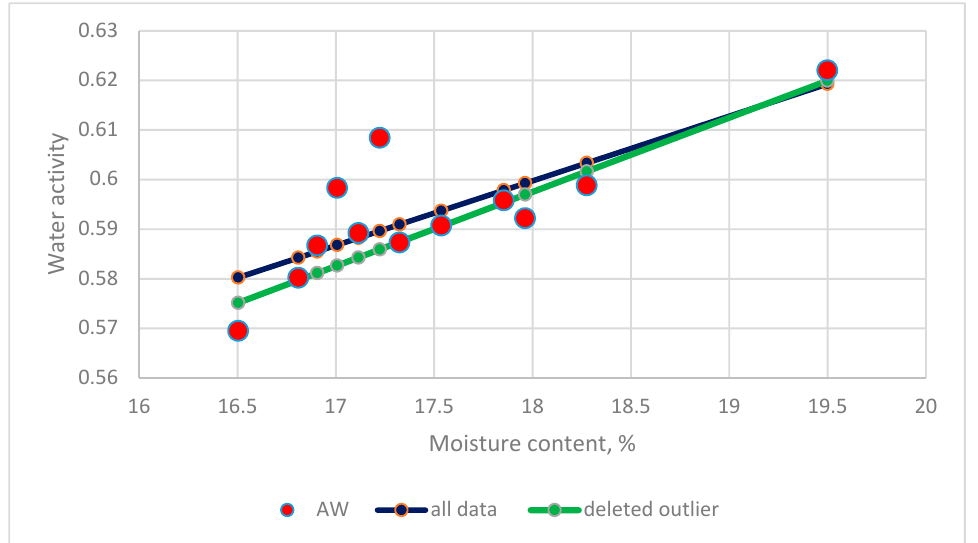
Figure 13. The comparison between two equations with and without outliers in the datasets of Sanjuan et al. [9].